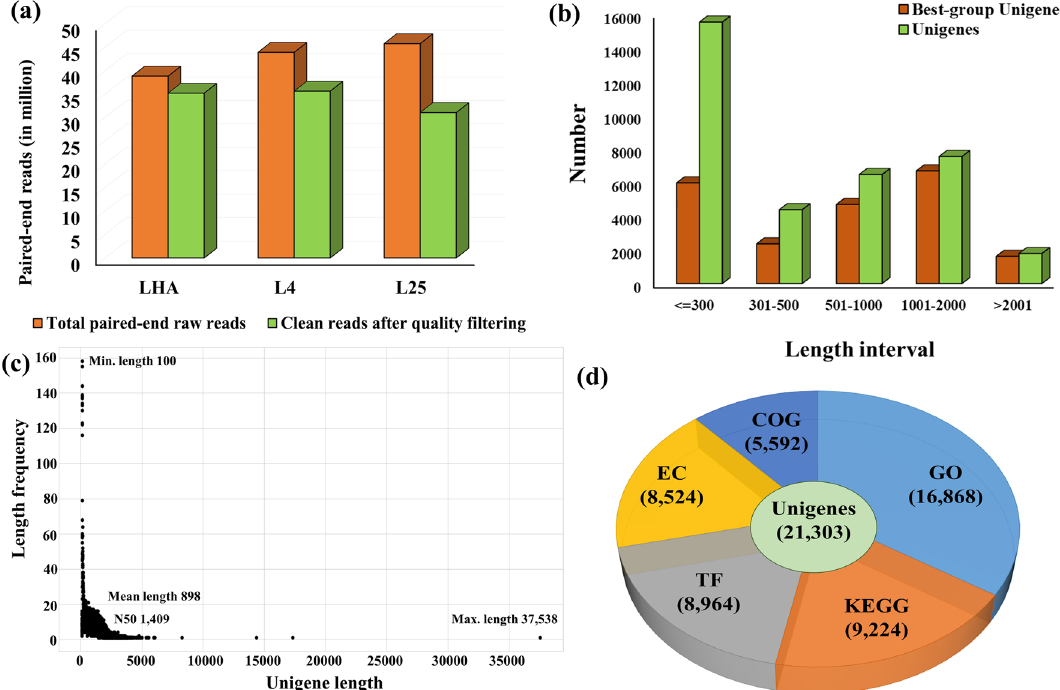
Figure 1. Overview of Rheum australe transcriptome read generation, assembly, and annotation of unigenes. (a) Paired-end (PE) read generation on Illumina Genome Analyzer IIx. X-axis indicates the analysis conditions where leaf samples were collected from the plants grown in growth chambers maintained at 4 °C (L4), 25 °C (L25), and the plants growing naturally in the niche location (LHA), y-axis indicates the number of PE raw and clean read. (b) Length distribution of unigenes and best group unigenes obtained from de novo assembly. (c) Best group length frequency distribution of unigenes. (d) The number of unigenes annotated against Non- Redundant (NR), Clusters of Orthologous Groups (COG), Gene Ontology (GO), Kyoto Encyclopedia of Genes and Genomes (KEGG) databases, and Enzyme Commission